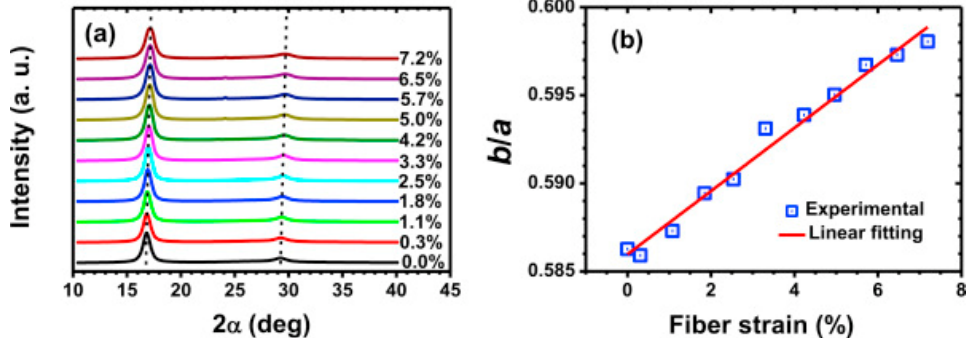
Figure 11. ( a ) Equatorial scans of PANFs at different fiber strains. Dashed lines guide the change in peak positions. ( b ) Variation of b/a value as a function of the fiber strain of PANFs. The listed symbols denote the experimental value, and the solid line is a linear fitting to the experimental values from calculated in situ 2D wide-angle X-ray scattering (WAXS) results (reprinted with permission from [96] , copyright 2014 Elsevier).